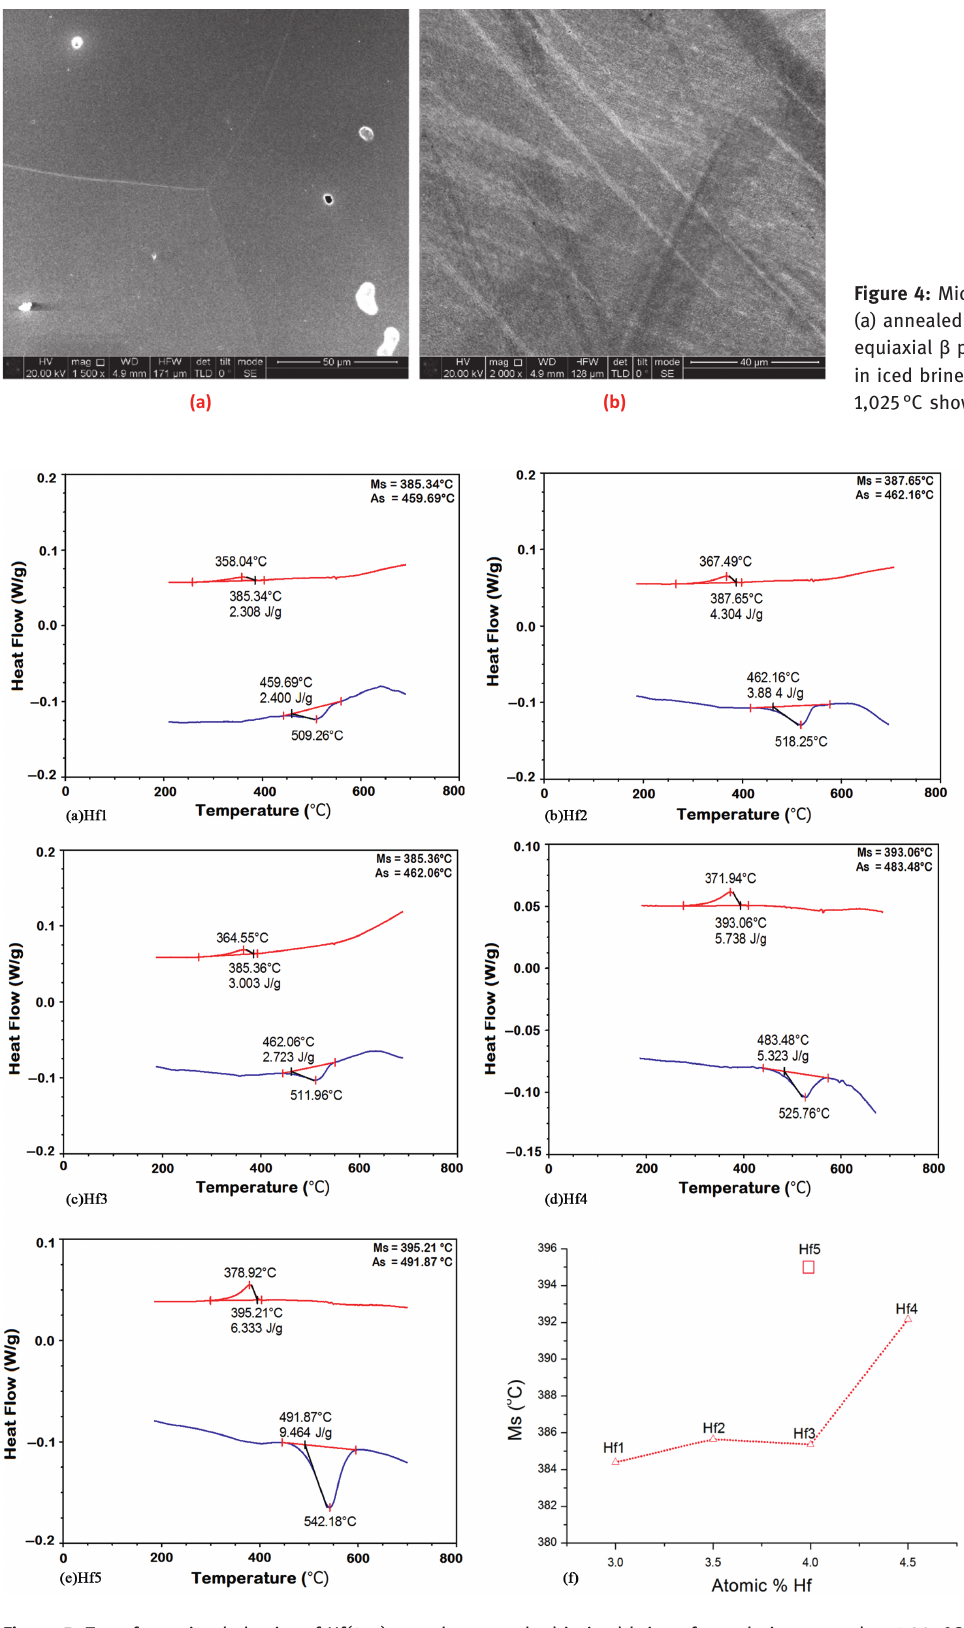
Figure 5: Transformation behavior of Hf(1 – 5) samples quenched in iced brine after solution treated at